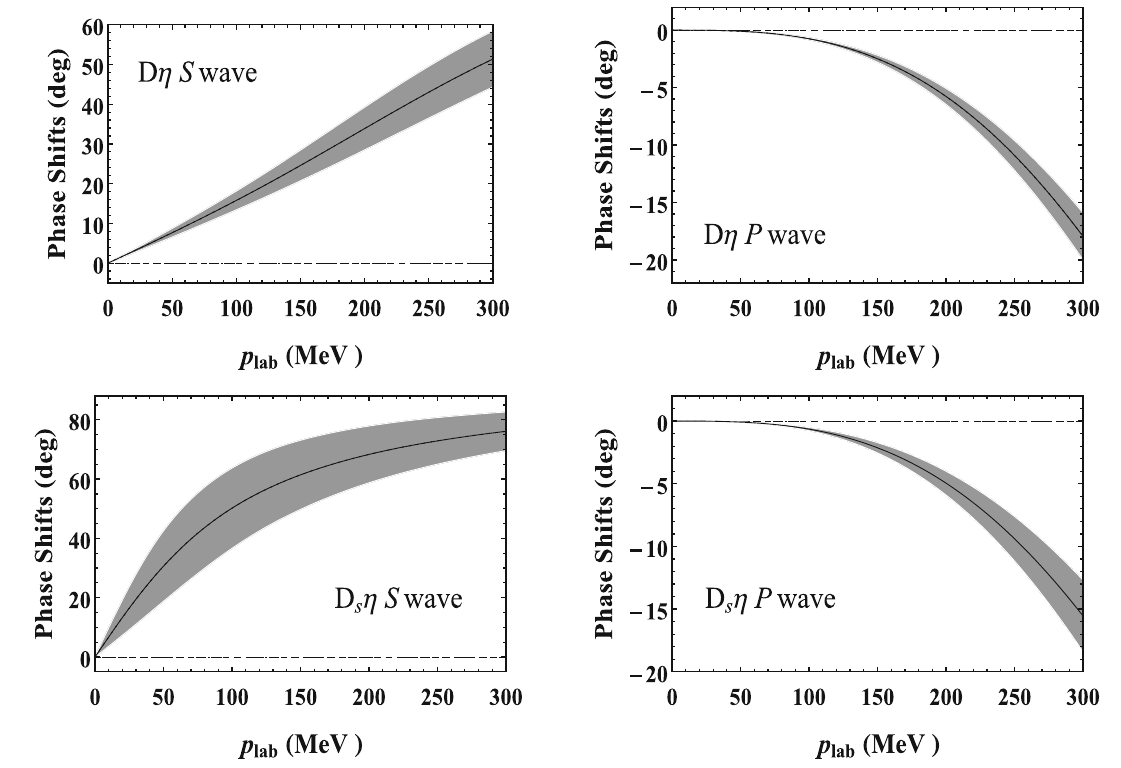
Fig. 6 Predictions for the eta- D meson phase shifts versus the eta laboratory momentum. The notation is the same as in Fig. 3 ¯ D π( I = 1 / 2 ) , D s K and D η may correspond to D ∗